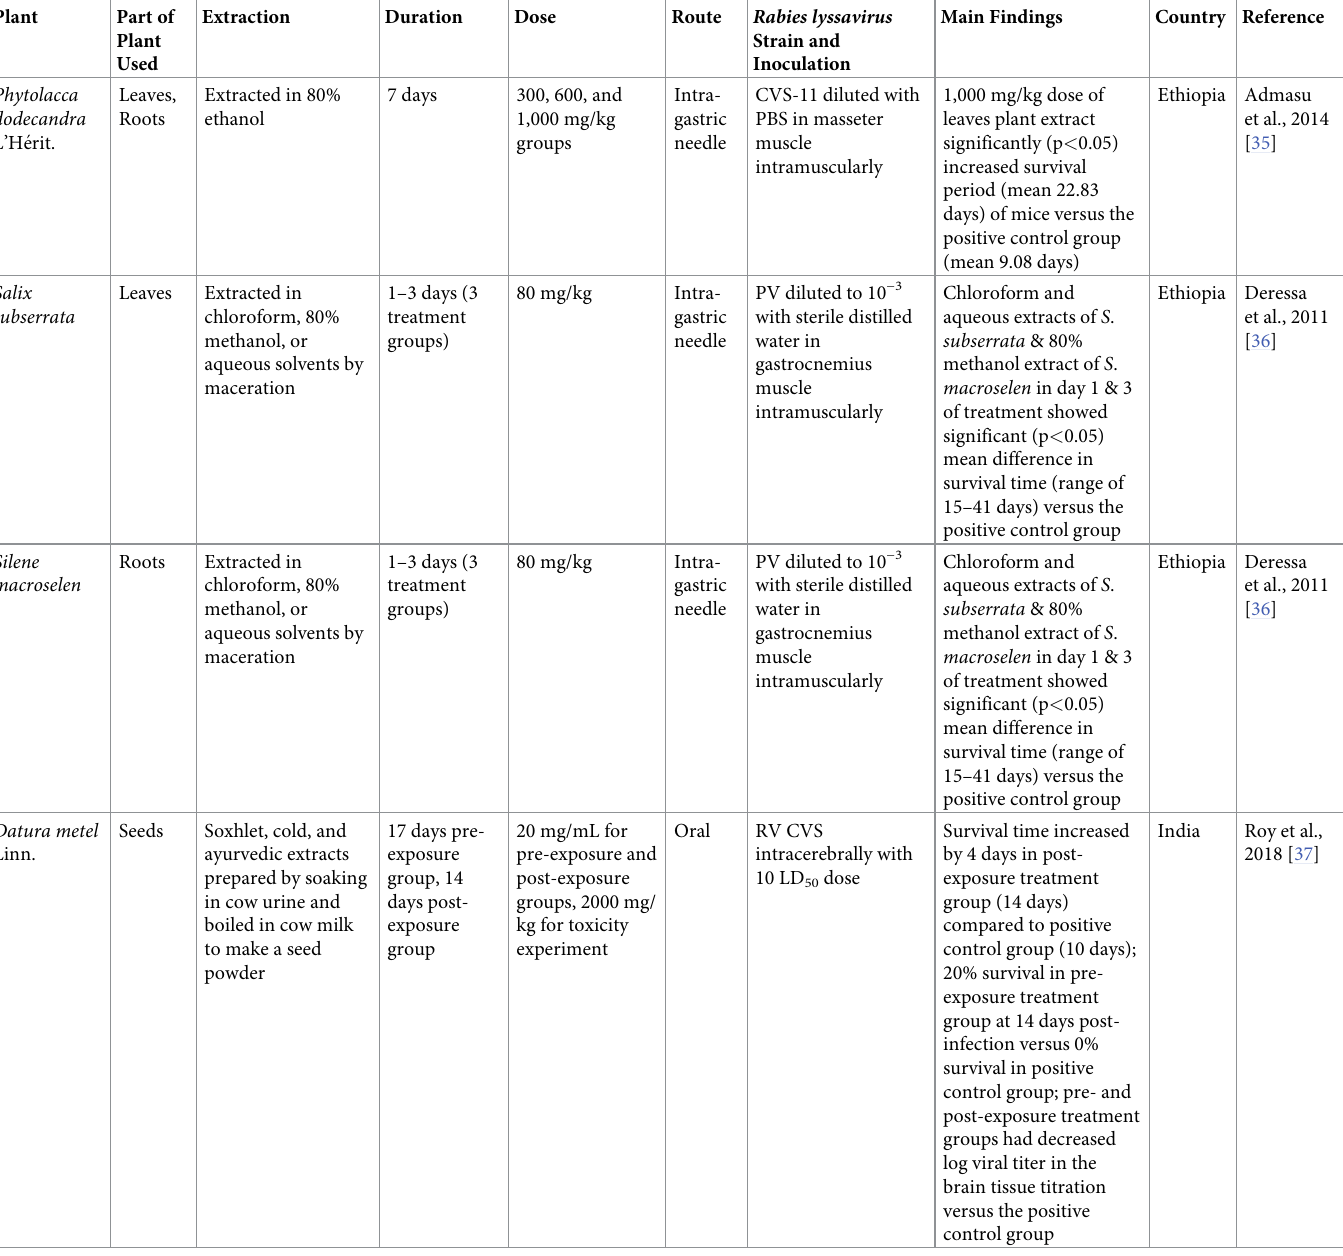
Table 3. Plants evaluated for treatment of mice inoculated with RABV in three controlled